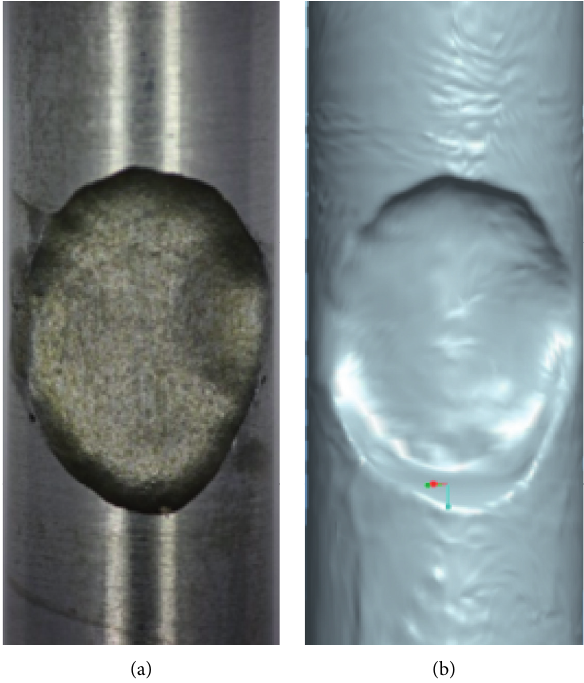
Figure 4: Specimen FC3 and the reconstructed 3D surface model. (a) The actual specimen and the corrosion pit and (b) the reconstructed 3D surface model of the specimen using laser scanning data.